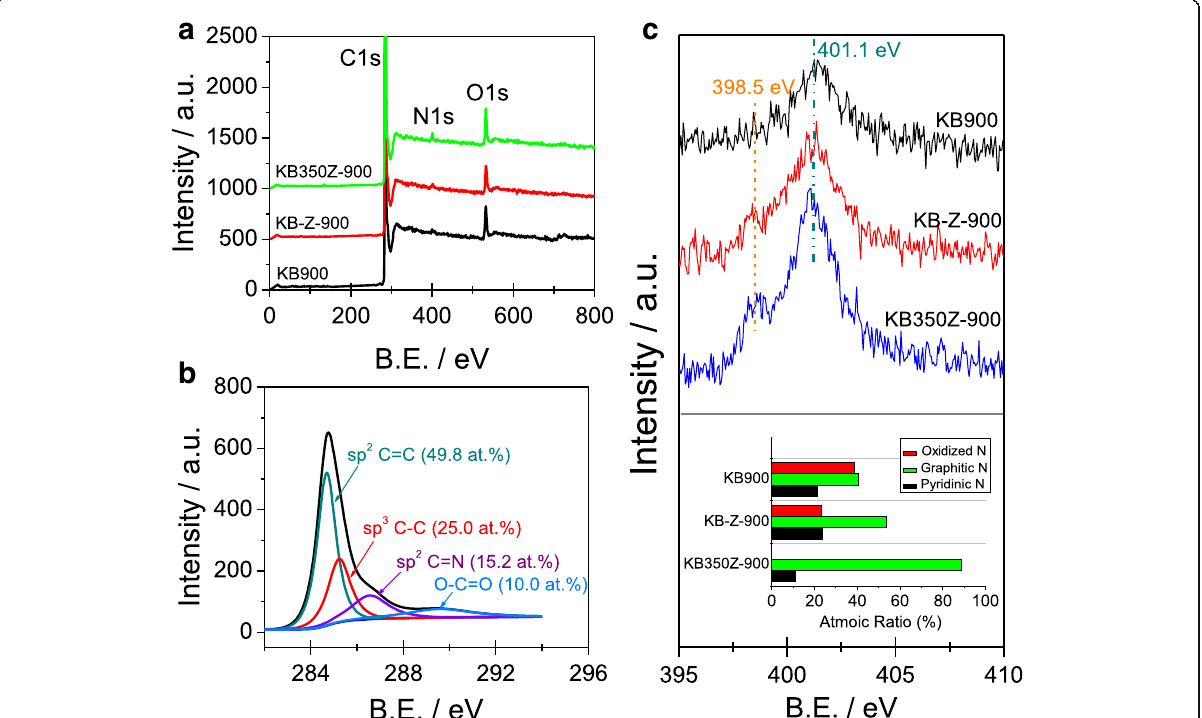
Fig. 2 a XPS survey of KB900, KB-Z-900 and KB350Z-900; b C1s XPS spectrum of KB350Z-900; c N1 s XPS spectra of KB900, KB-Z-900 and